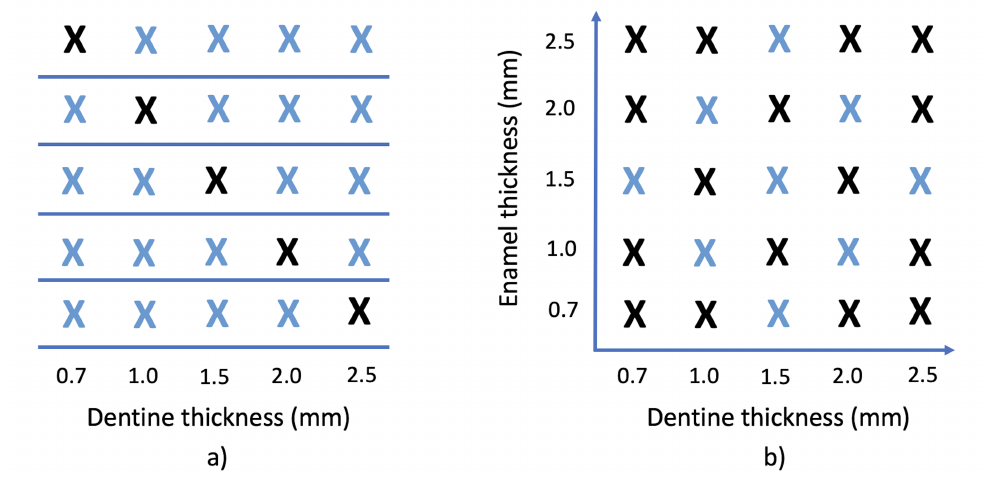
Figure 1. Samples included in the training set (blue) and testing set (black). ( a ) For monolithic samples, each thickness is used as a test sample while the other four thicknesses are included in the training set. ( b ) For bi-layered samples, 25 dentine + enamel combinations are obtained and divided into 9-samples training set and 16-samples testing